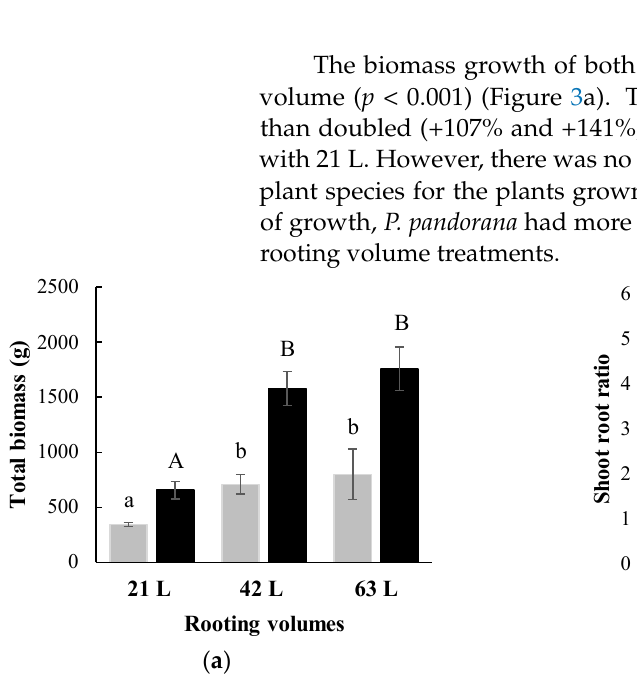
( d ) Figure 2. Percentage wall coverage of Akebia quinata ( a , c ) and Pandorea pandorana ( b , d ) grown in three different rooting